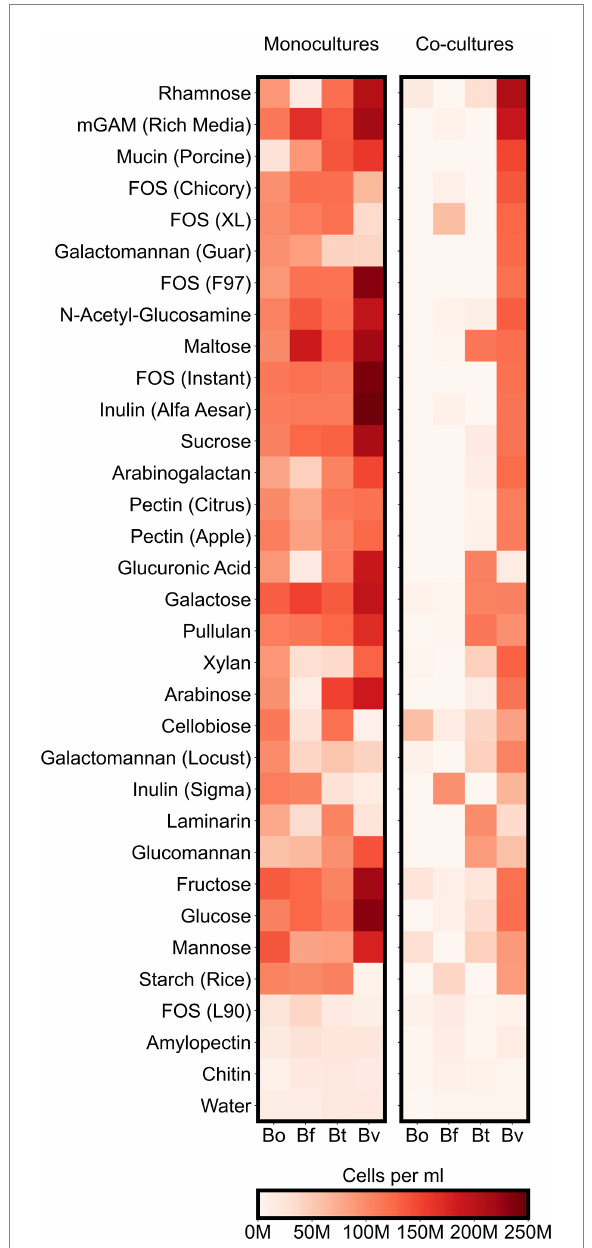
FIGURE 4 Maximum species concentrations on each tested substrate. For each species, heatmaps display the highest abundances (cells per ml) observed at any of the sampled timepoints either in monocultures or co-cultures. “M” indicates values in the